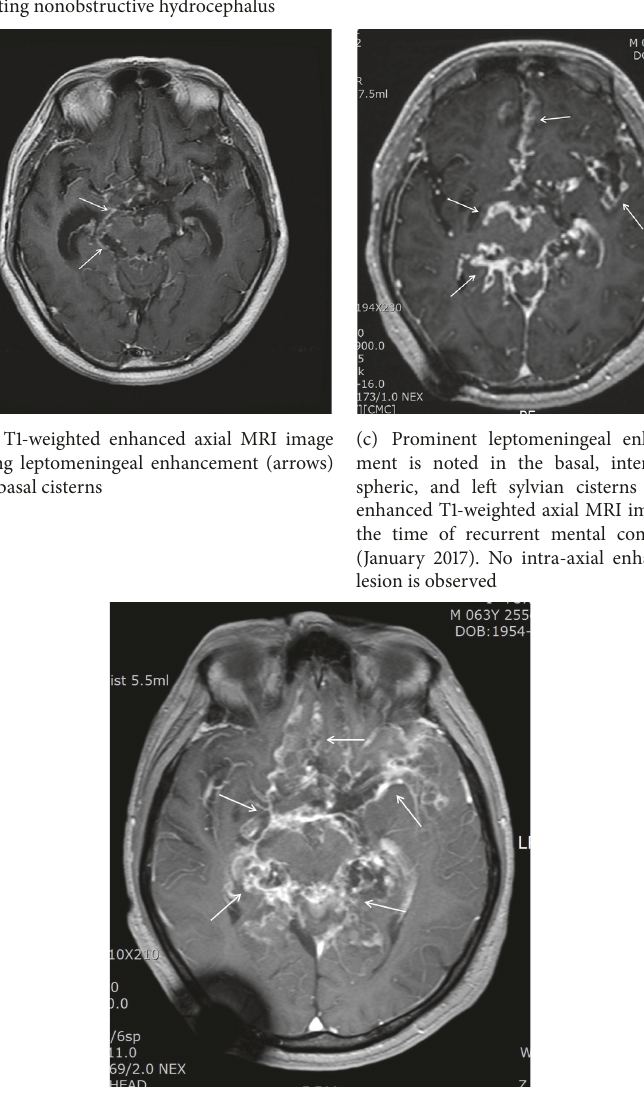
cisterns in an enhanced T1-weighted axial MRI image in August 2017 Figure 1: